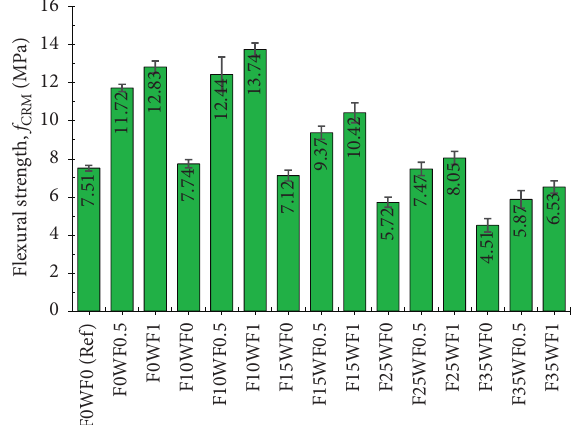
Figure 12: The ratio between f